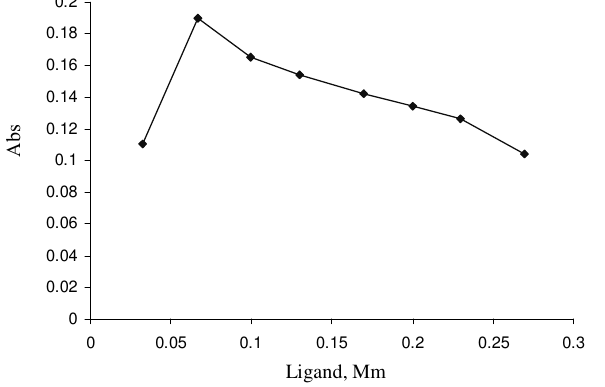
Figure 4. Effect of BHIS concentration on the absorbances of silver